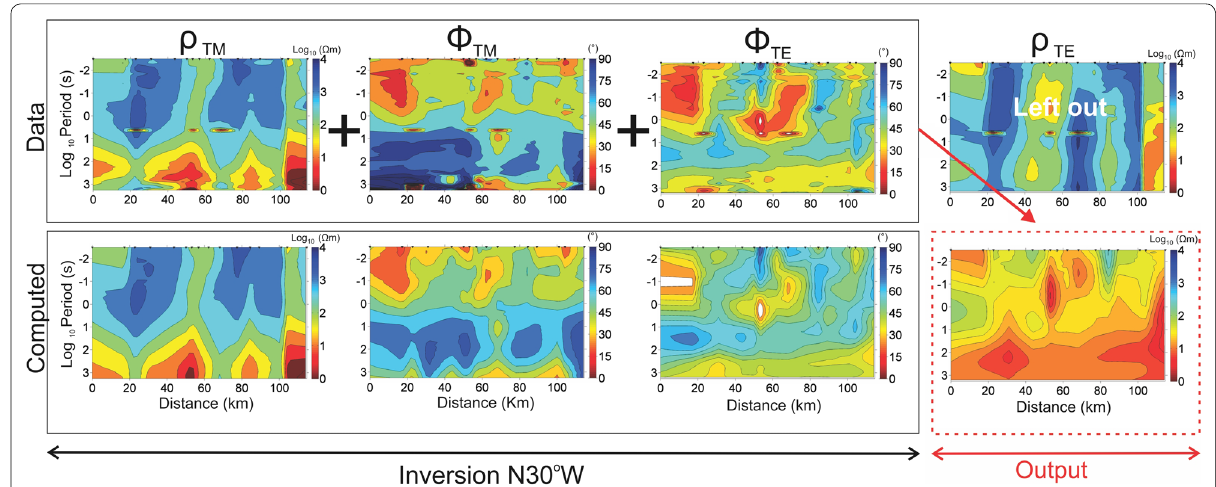
Fig. 4 Fit to the data for a strike direction of 30° or N30°W. The upper images are the data pseudo‑sections and the ones below are the − corresponding responses of the model. Notice that the pseudo‑sections of the TE apparent resistivity don’t look alike at all in this case. The other three pairs indicate a good fit to the data. The TE apparent resistivity was not part of the inversion